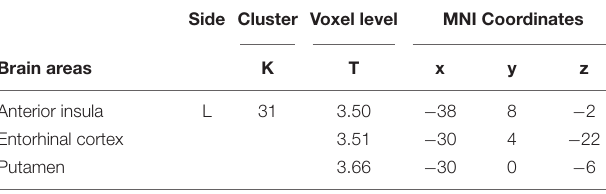
TABLE 2 | Significant areas of activation for the comparison “DJ vs. N” (cluster size threshold k ≥ 24, corrected at α < 0.05).